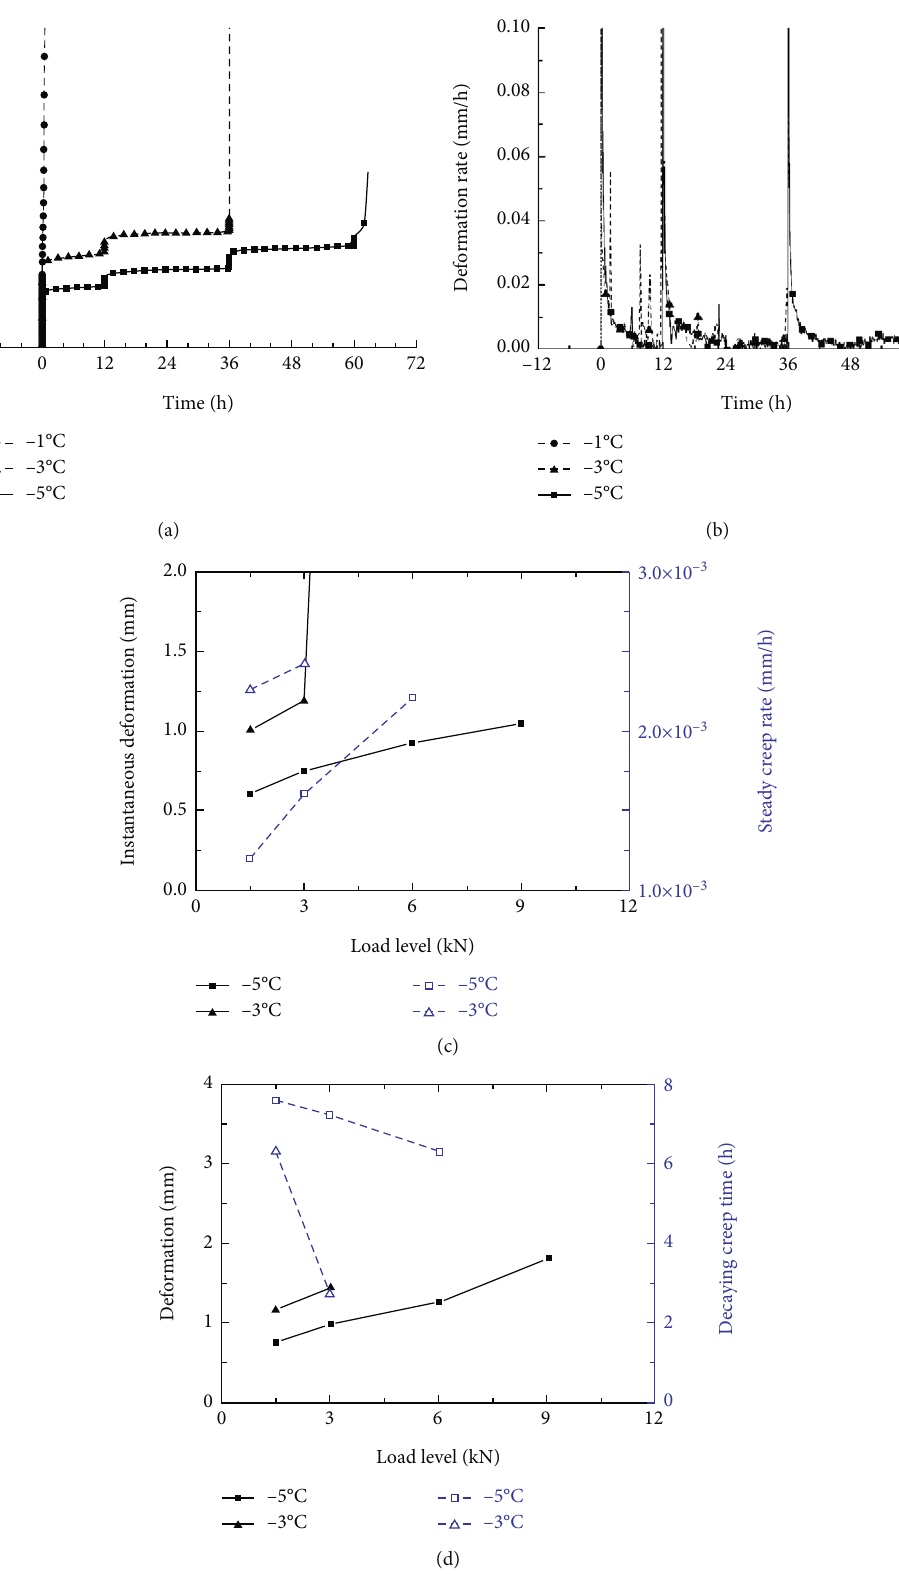
Figure 6: Creep parameters of the pile-frozen soil interface subjected to di ff erent given